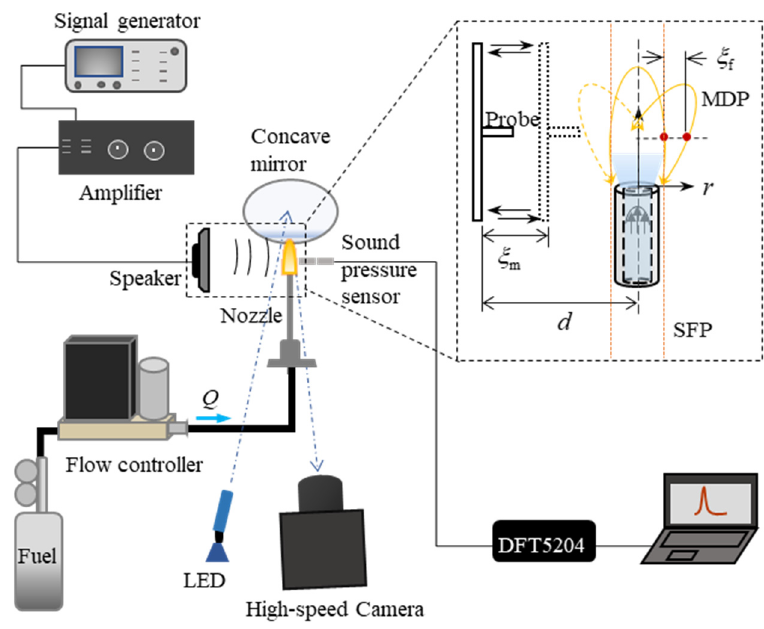
Figure 1. Scheme of experimental setup.